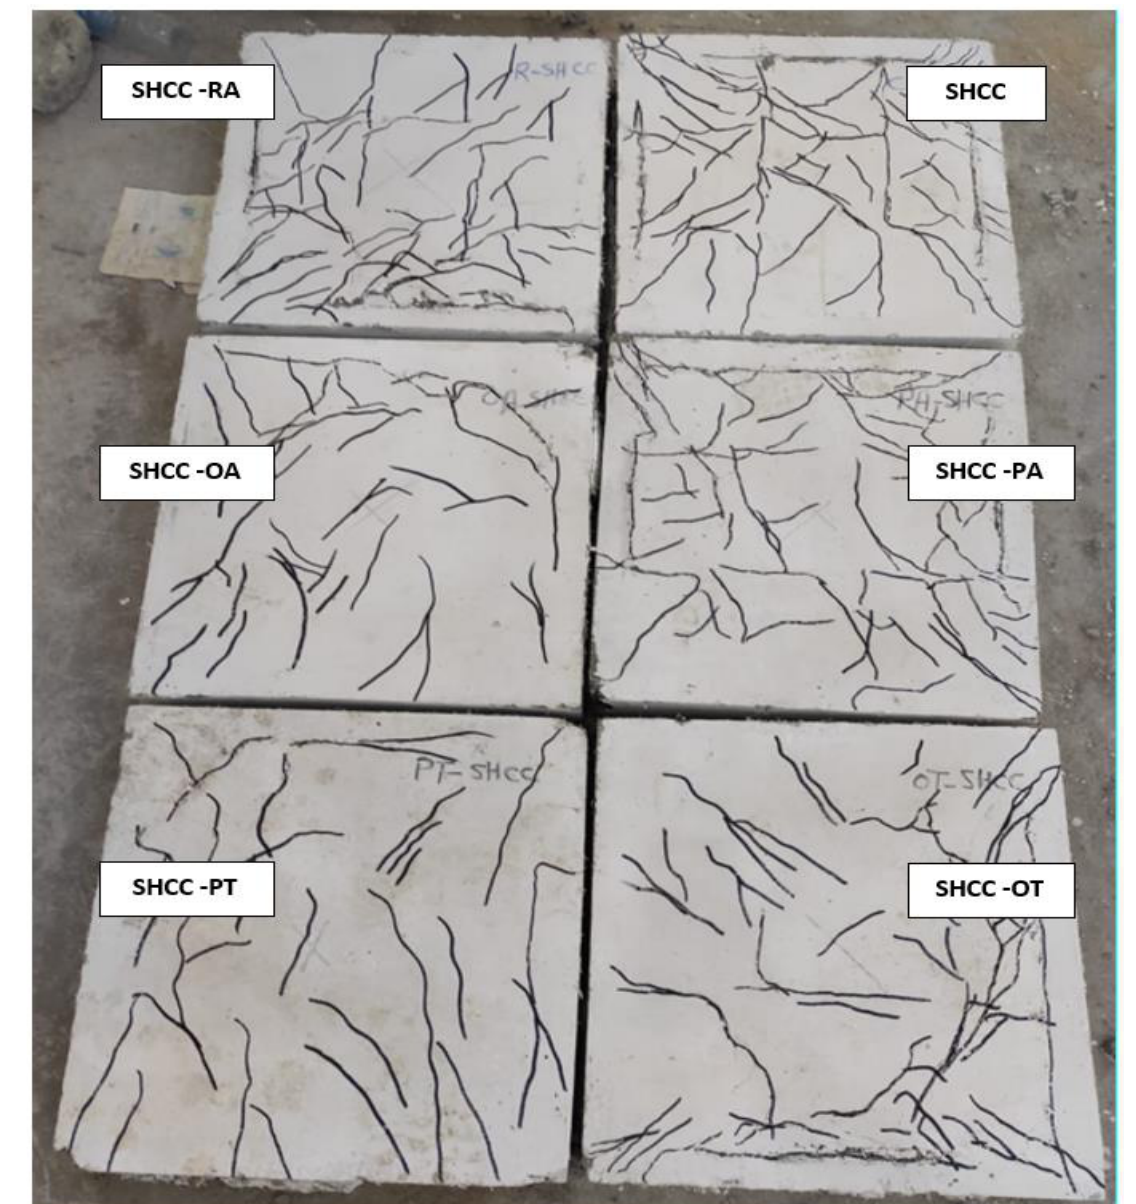
Figure 9. SHCC specimens cracks.